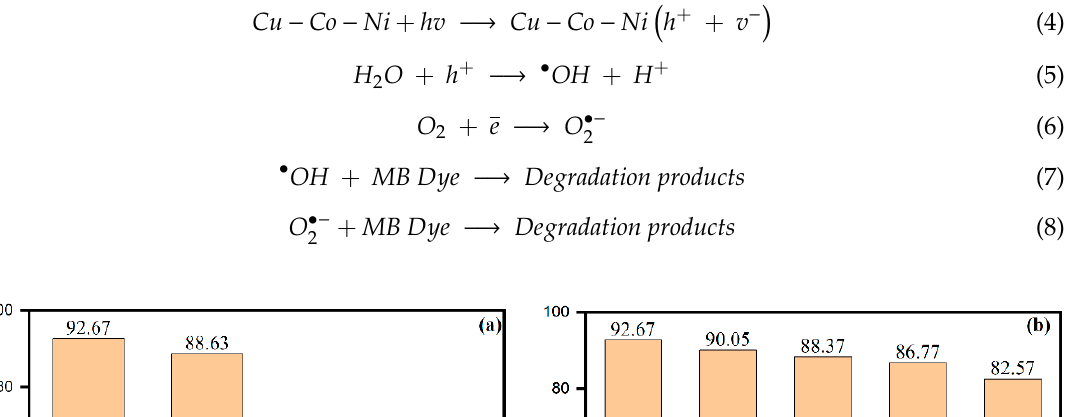
Figure 11. Possible mechanism of photodegradation of MB by Cu-Co-Ni nanoparticles.